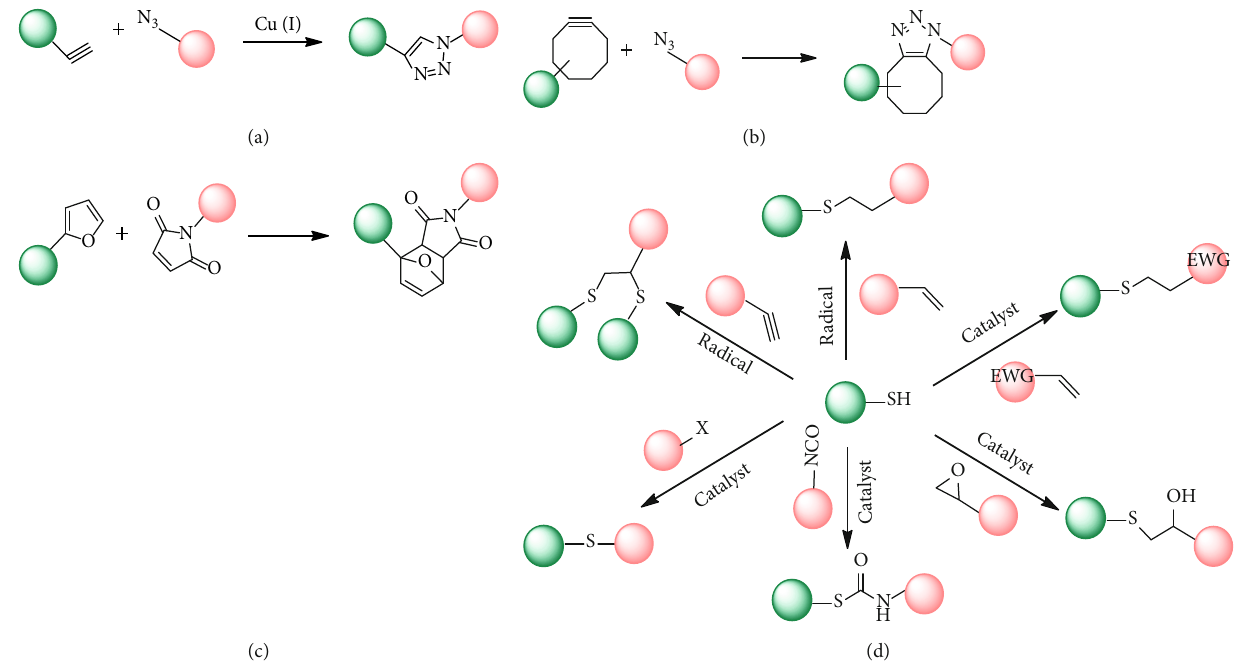
Figure 2: Schematic illustrations of the typical “ click ” reactions: (a) Cu (I)-catalyzed cycloaddition of alkynes and azides (CuAAC), (b) strain- promoted cycloaddition of alkynes and azides (SPAAC), (c) Diels-Alder reaction, and (d) thiol-involved reactions.